Question: Briefly state, in one sentence, what is plotted here.
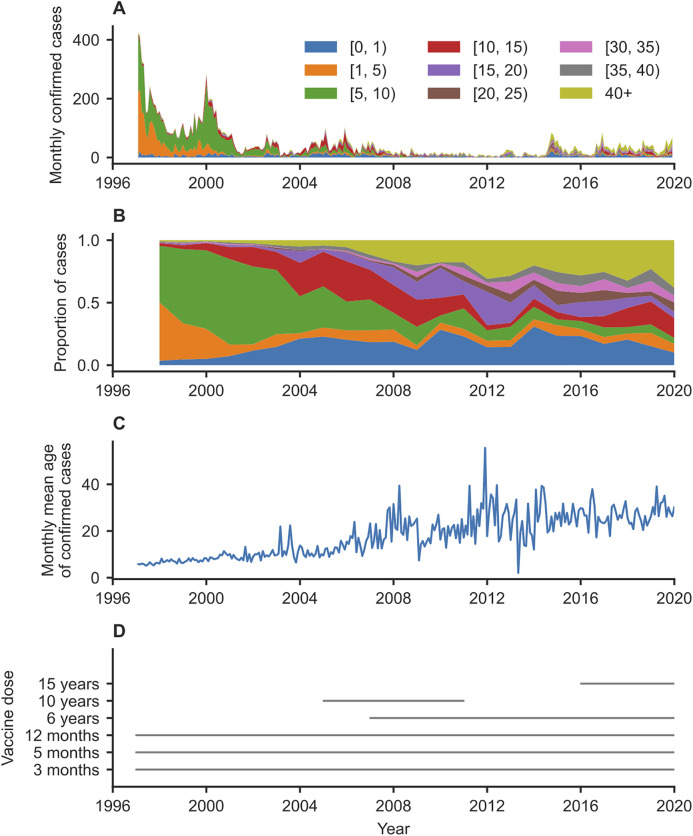
Answer: Pertussis cases and vaccine schedule in Sweden. A) Annual laboratory test confirmed cases of pertussis from 1997 until 2020 by age group. After the introduction of routine vaccination in 1997, confirmed cases in individuals eligible for vaccination dropped rapidly (age groups [1,5) years and [5, 10) years). The decline in cases among the at-risk [0, 1) years age group was less pronounced. Post-2014 there was an apparent increase in notifications for both the [0,1) and 10+ age groups. B) Proportion of confirmed cases by age group. Following the introduction of vaccination, confirmed cases showed a pronounced shift to older ages. C) Mean age of confirmed cases by month. D) Vaccine schedule in Sweden. Beginning in 1997, 3-dose primary vaccination with DTaP was added to the vaccine schedule. From 2005 onwards, booster doses were added to the schedule: first at 10 years (DTaP; 2005–2011), then 6 years (DTaP; 2007–present) and 15 years (Tdap; 2016–present).